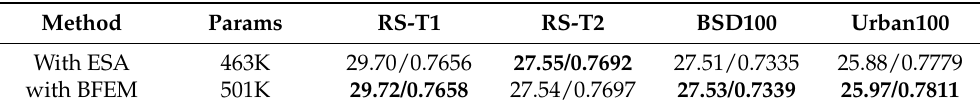
Table 4. Results of our model on four test sets after using ESA or BFEM. Method Params RS-T1 RS-T2 BSD100 Urban100 With ESA